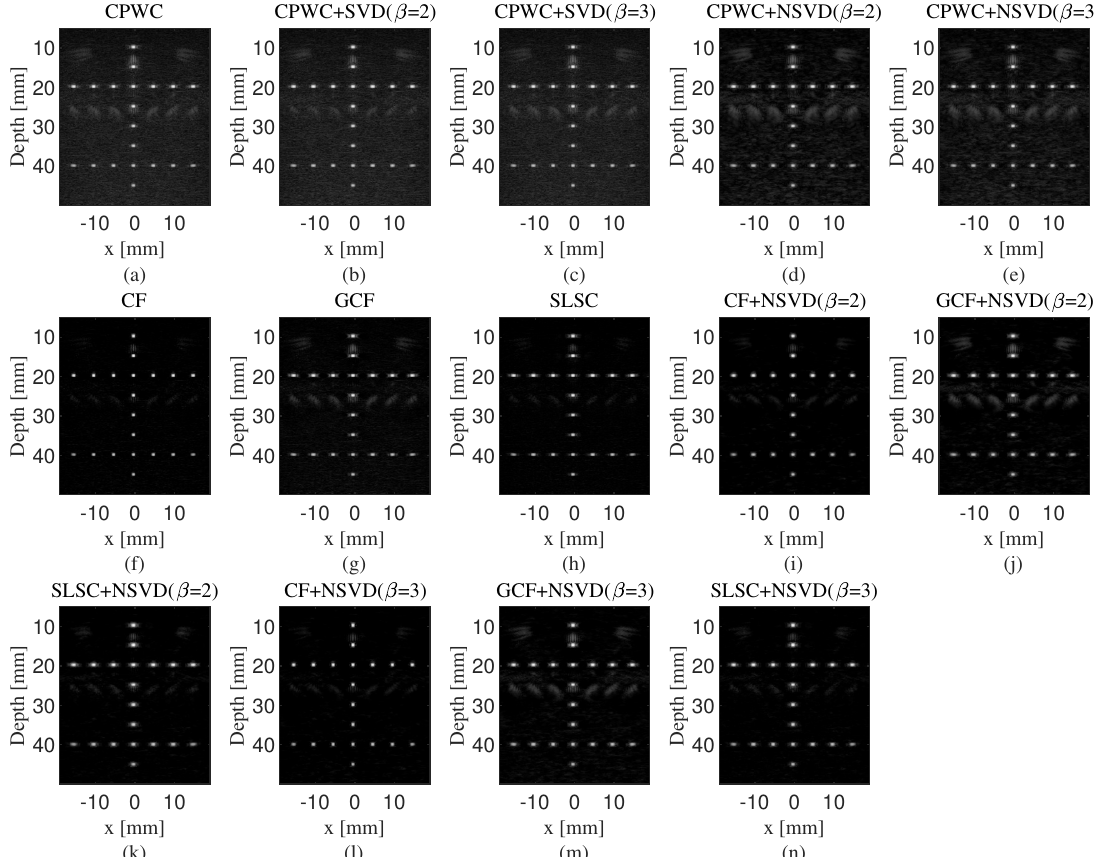
Figure 1. B-mode images of simulated phantom with point targets formed by different methods. ( a ) CPWC, ( b ) CPWC+SVD ( β = 2), ( c ) CPWC+SVD ( β = 3), ( d ) CPWC+NSVD ( β = 2), ( e ) CPWC+NSVD ( β = 3), ( f ) CF, ( g ) GCF, ( h ) SLSC, ( i ) CF+NSVD ( β = 2), ( j ) GCF+NSVD ( β = 2), ( k ) SLSC+NSVD ( β = 2), ( I ) CF+NSVD ( β = 3), ( m ) GCF+NSVD ( β = 3), ( n ) SLSC+NSVD ( β =